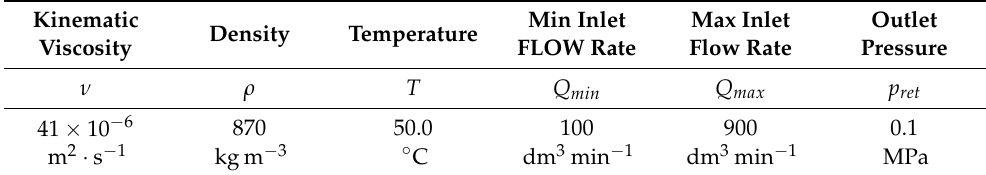
Table 1. Physical model